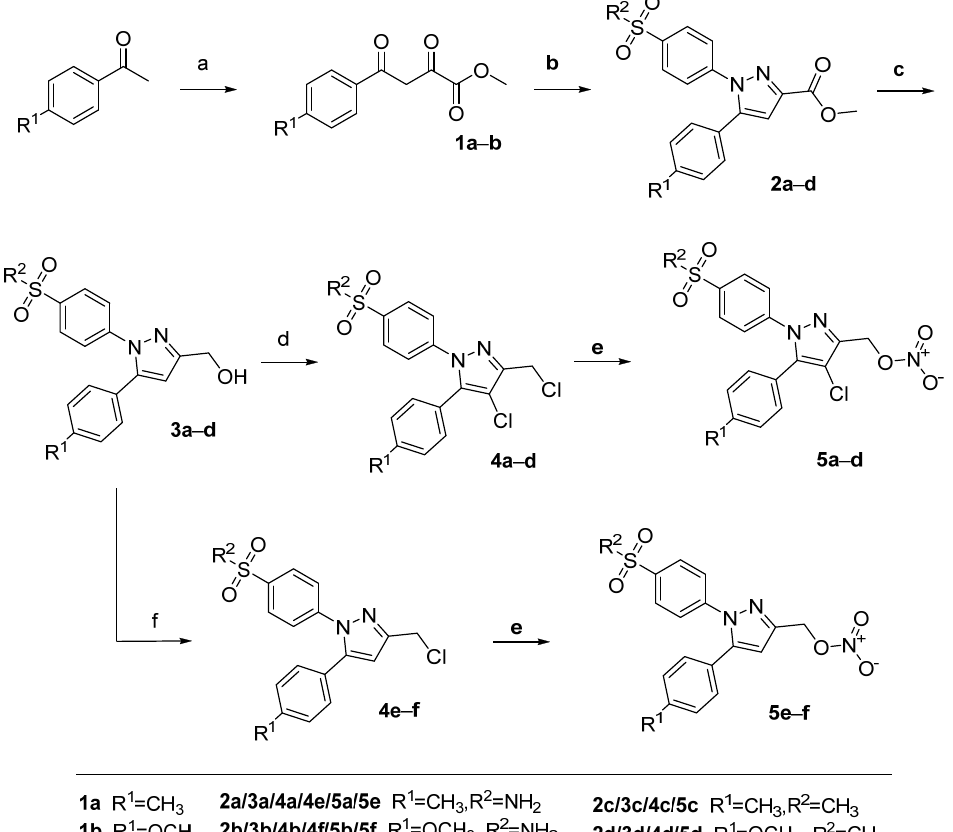
Figure 2. Aim of this